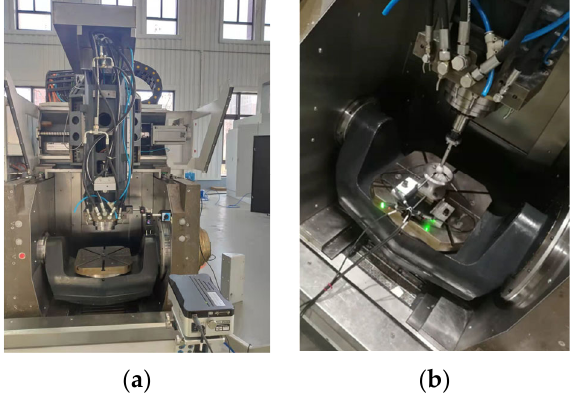
Figure 10. Measurement of the geometric errors of the machine tool. ( a ) Laser interferometer measures geometric errors of translational axes; ( b ) R ‐ Test measures geometric errors of rotary axes.